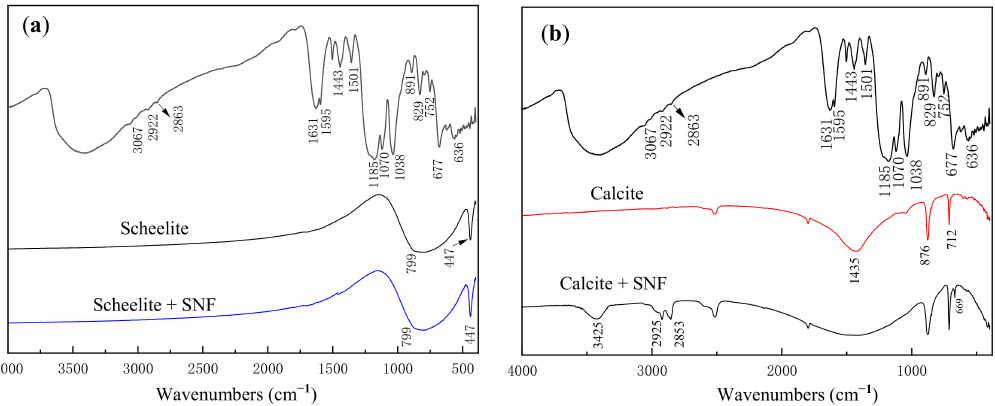
Figure 9. FTIR spectra of scheelite ( a ) and calcite ( b ) in the presence and absence of SNF at pH 9.